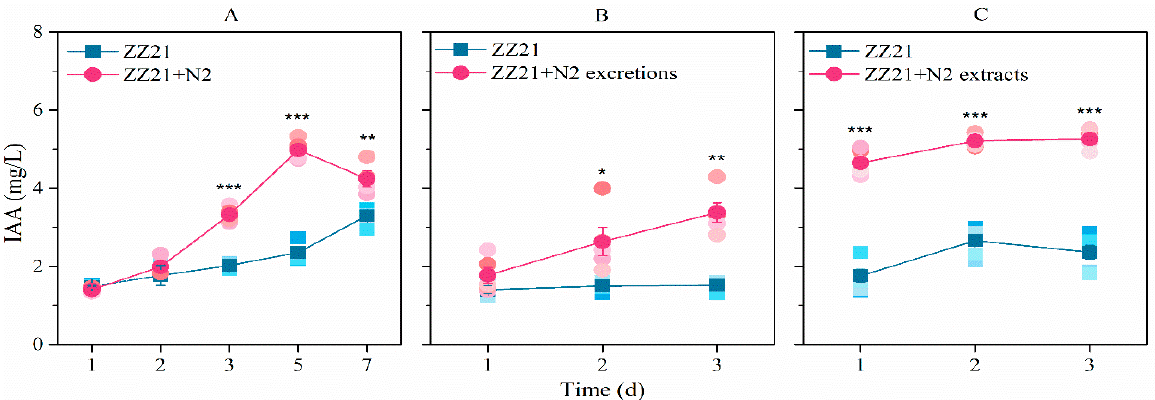
Figure 3. C. elegans N2 ( A ), their excretions ( B ) and their extracts ( C ) increase the ability of A. pascens ZZ21 to synthesize IAA. Asterisks indicate significant differences (* p < 0.05, ** p < 0.01, *** p < 0.001). Data are expressed as mean ± SE .